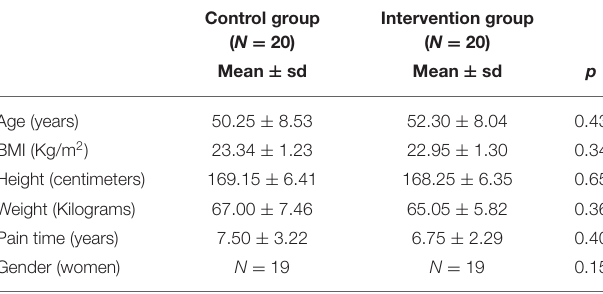
TABLE 1 | Sociodemographic data from the control and intervention